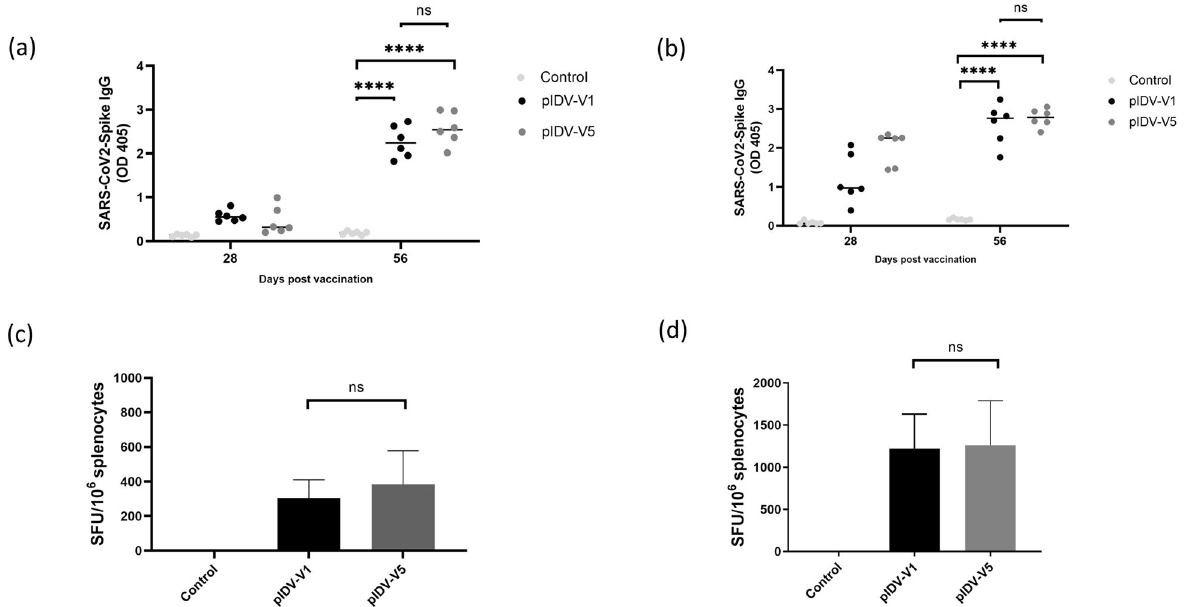
Fig. 2 Humoral and cell-mediated responses in vaccinated mice. a BALB/c and b C57BL/6 mice were immunized with pIDV-II-SARS-CoV2- Spike-V1 (pIDV-V1), pIDV-II-SARS-CoV2-Spike-V5 (pIDV-V5), or sham vaccination with buffer only (control). Spike-speci fi c antibodies was detected by ELISA. All mice received two doses of vaccine, one on day 0 and another on day 28 ( n = 4 per group per timepoint). Each dose of vaccine was administered via electroporation (EP) following intramuscular injection of 50 µg/dose (ug DNA by IM + EP route). (sera dilution 1:400). **** indicates P value = <0.0001 as determined by one-way ANOVA. Error bars represent standard deviation. T cell response was analyzed by ELISpot 10 days after boost in c BALB/c and d C57BL/6 mice. Sham immunized mice were used as control. Splenocytes cell suspension were stimulated with SARS-CoV2 peptide pools encompassing the entire SARS-CoV2 Spike glycoprotein. No signi fi cant difference was observed for the cell-mediated response between vaccinated animals with two versions of